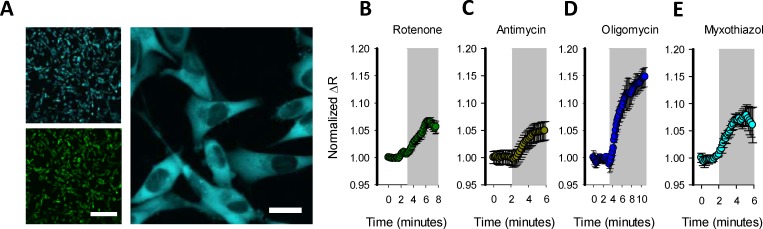
Characterization of “MitoTox reporter” cell line.A) Confocal images from FACS selected clonal MDA-MB-231 cells expressing Laconic. Size bars for 20x and 60x represent 100 μm and 10 μm, respectively. Cytosolic lactate accumulation induced by treatment with: B) 32 μM rotenone, C) 16 μM of antimycin, D) 80 μM of oligomycin, and 10 μM myxothiazol. Each trace is the average of ten cells from one representative experiment.